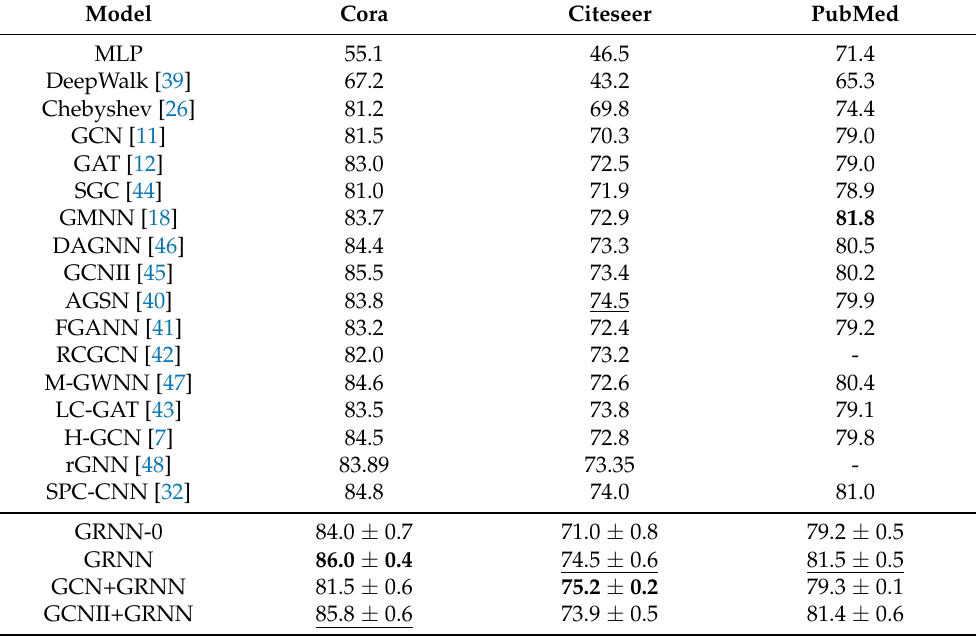
Table 2. The performance comparison of GRNN with existing graph neural network methods (%).